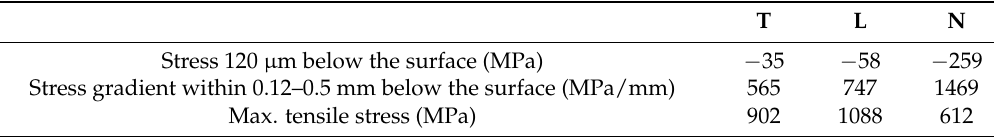
Table 4. A summary of the main residual stress results for position SS-WT in the transverse (T), longitudinal (L) and normal (N) directions, extracted from Figure 6.